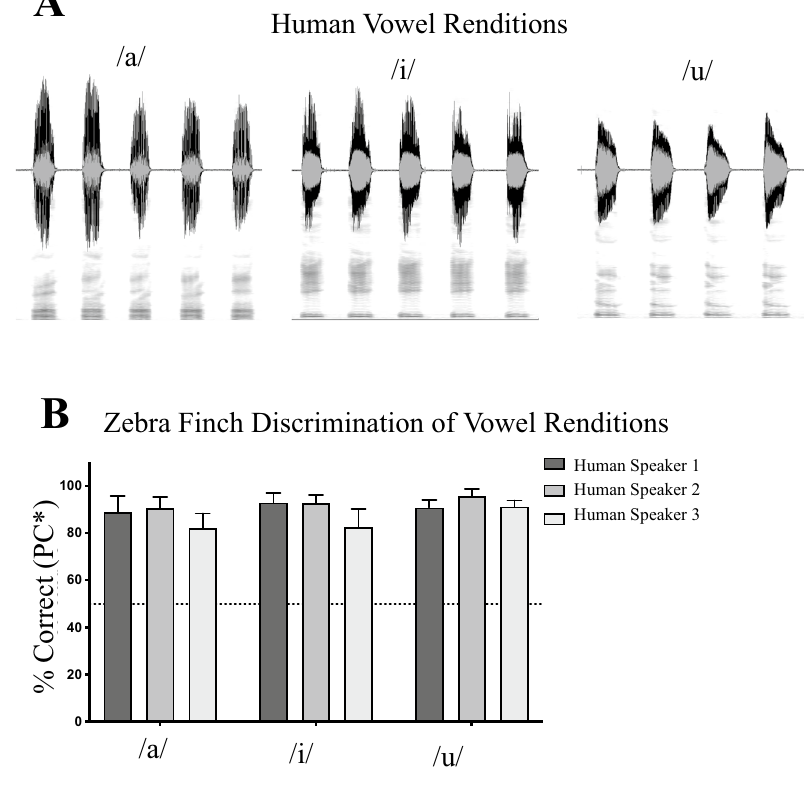
Figure 3. ( A ) Time waveform (top) and spectrogram (bottom) of a single human speaker producing the sustained vowels: /a/ /i/ /u/, as in “father”, “eat”, and “goose” respectively (made in Sonic Visualiser 51 ). To prepare vowels for psychoacoustic tests, the middle section of a sustained vowel was extracted and given a 5 ms cosine rise/fall time. ( B ) Performance (PC*, mean ± SEM, N = 3) on discriminating the different renditions of extracted vowels from three human